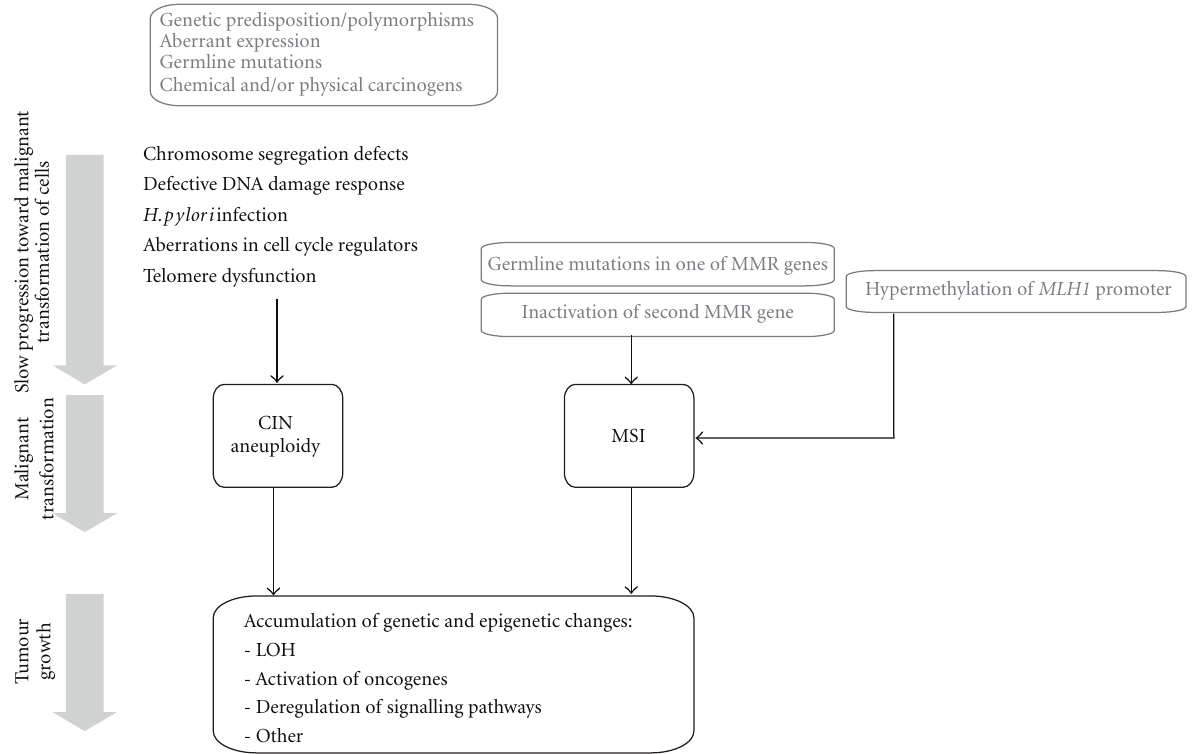
Figure 1: The pathogenic mechanisms inducing CIN or MSI lead to gastric cancer